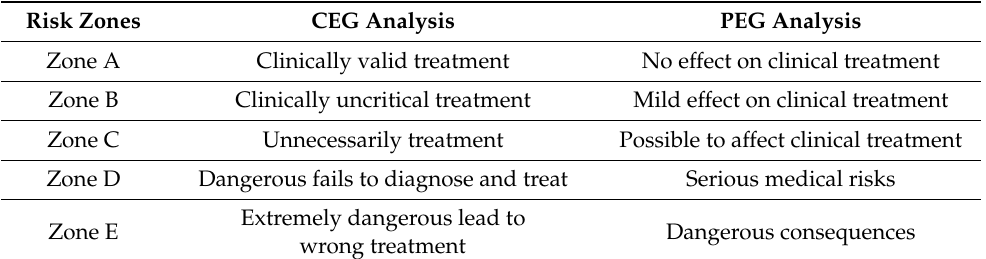
Figure 15. Error grids plots: ( a ) CEG and ( b ) PEG for glucose monitoring. Reprinted with permission from [13]. Table 3. Error Grids Analyses [5,13,28].